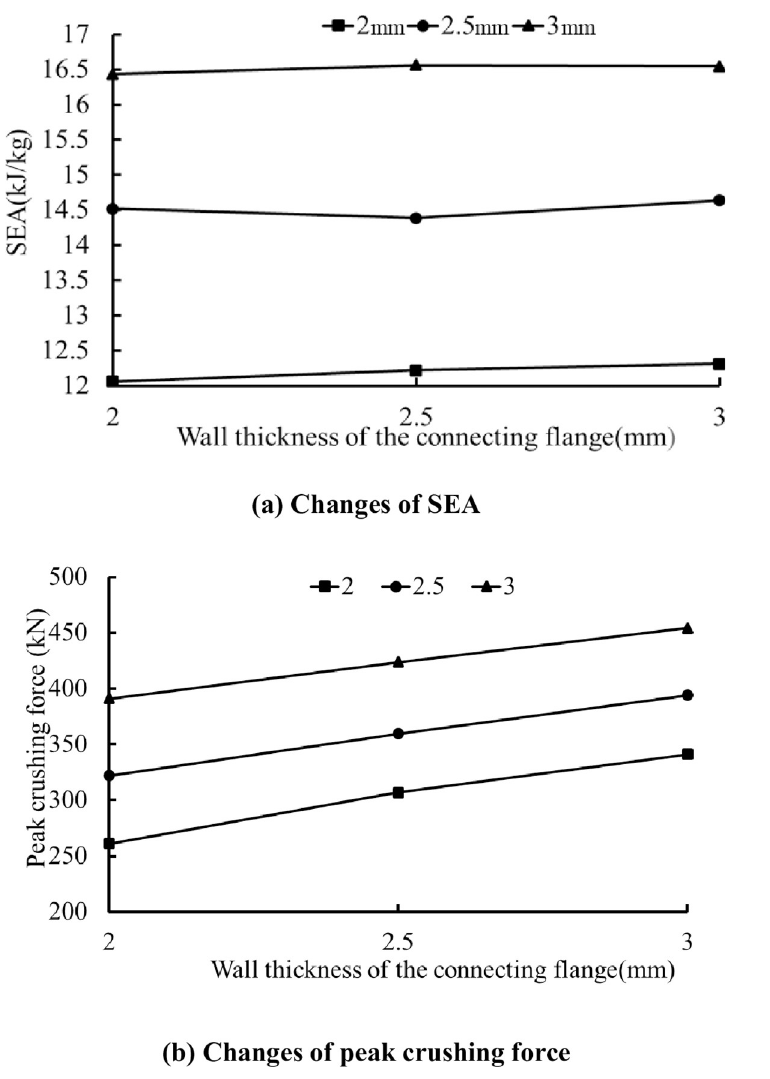
Fig 11. Effect of the thickness on the energy absorption and crushing